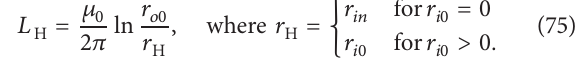
and 𝑃 values on 𝑘 , for the segment of J Js